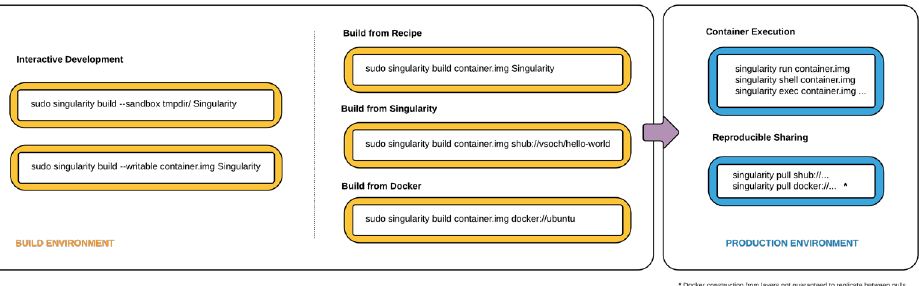
Figure 1. Singularity workflow: build step in privileged mode and execution step in unprivileged mode c (cid:30)